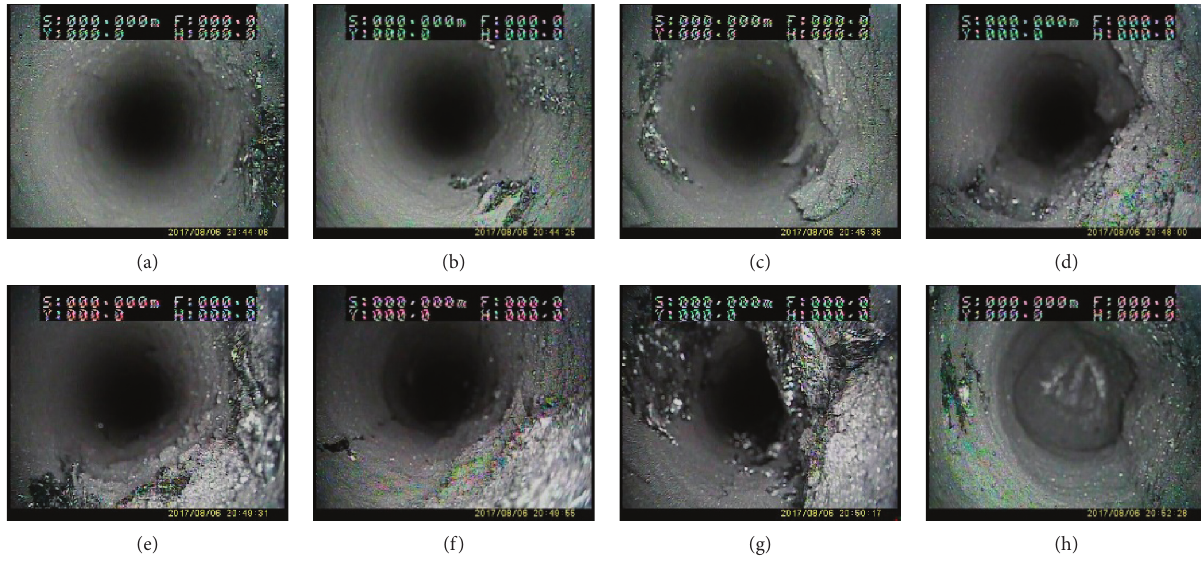
Figure 20: The distribution of the surrounding rock outside the anchor zone. (a) 2.6 m. (b) 3.2m. (c) 4.8 m. (d) 5.6 m. (e) 6.6m. (f) 7.8m. (g) 8.9m. (h) 10.0m.